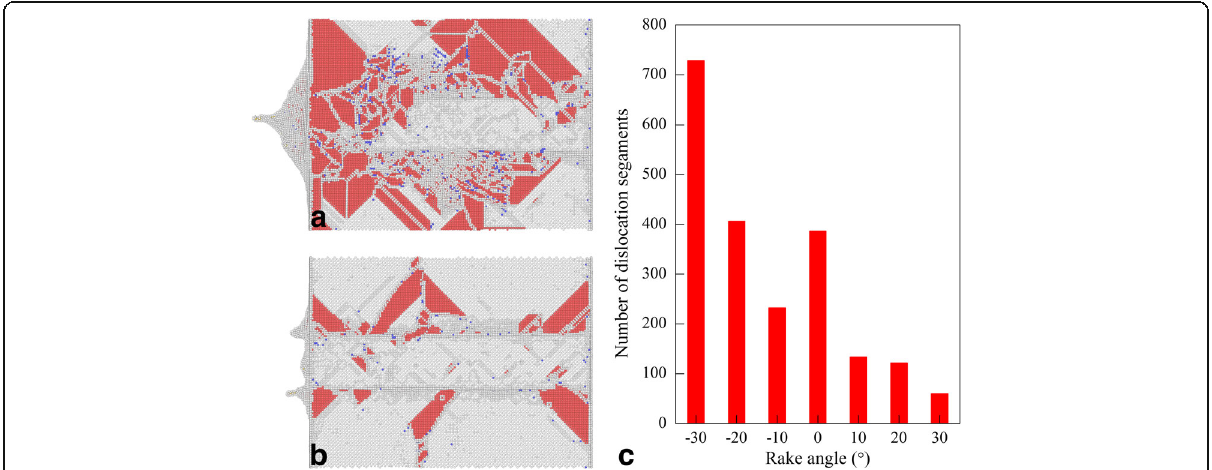
Fig. 7 Defect structures generated with different rake angles; (color online) MD snapshots of defect structures after cutting of Cerium with rake angle of a − 30° and b 30°. Atoms are colored according to their CNA values. c Rake angle-dependent dislocation